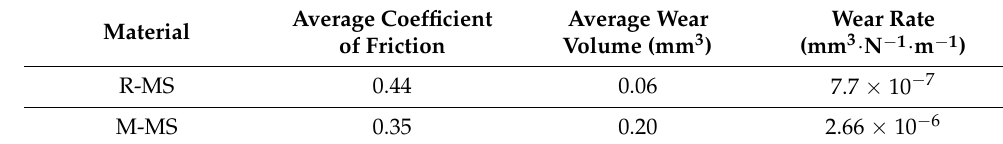
Table 3. Dry friction properties of MCMB-SiC composites.